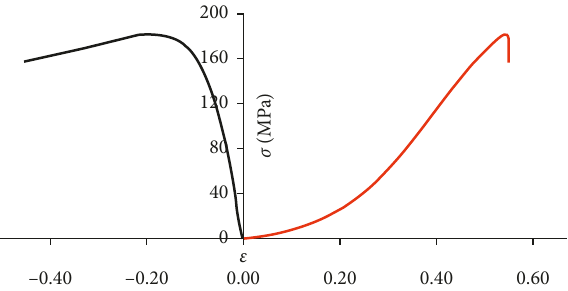
Figure 1: Relationship between the stress and the strain of the